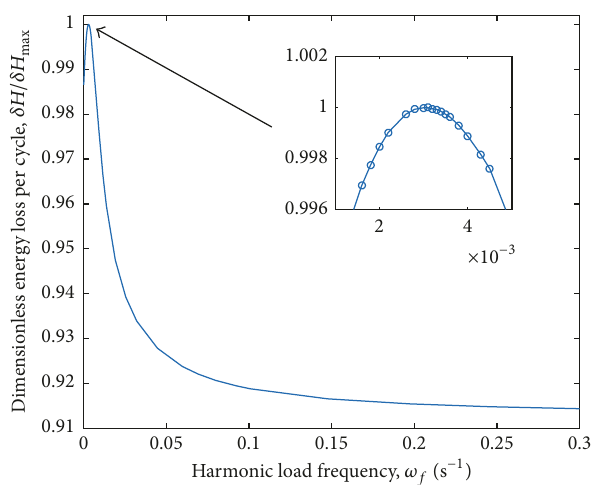
Figure 13: Energy loss versus harmonic load frequency in the PMMA